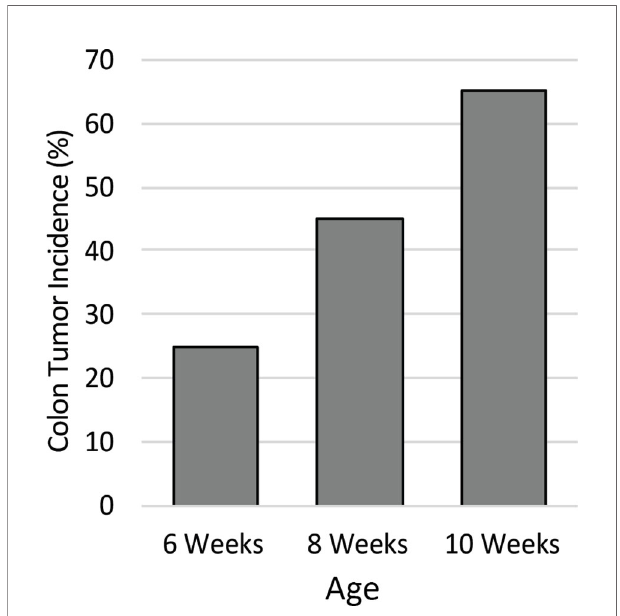
FIGURE 2 | Colon tumor incidence in Apc +/Min-FCCC mice over time. Animals (n=20) assessed by colonoscopy exhibited a linear increase in colon tumor incidence from 6 to 10 weeks of